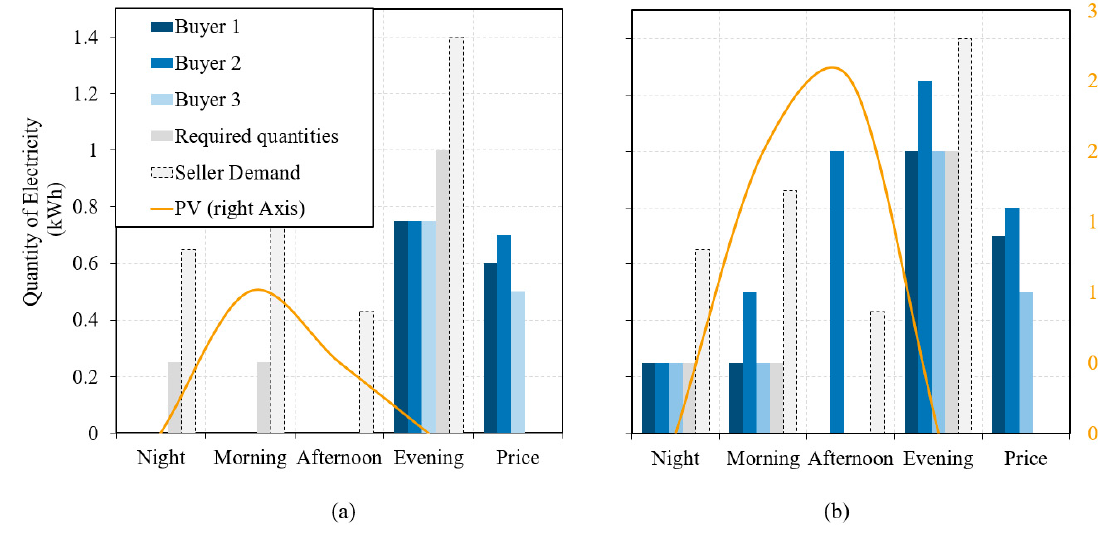
Figure 1. Outcomes of negotiations for the three di ff erent types of buyer agents implementing expert strategy against the seller, also implementing expert strategy; for the case of a cloudy day ( a ) and of a sunny day ( b